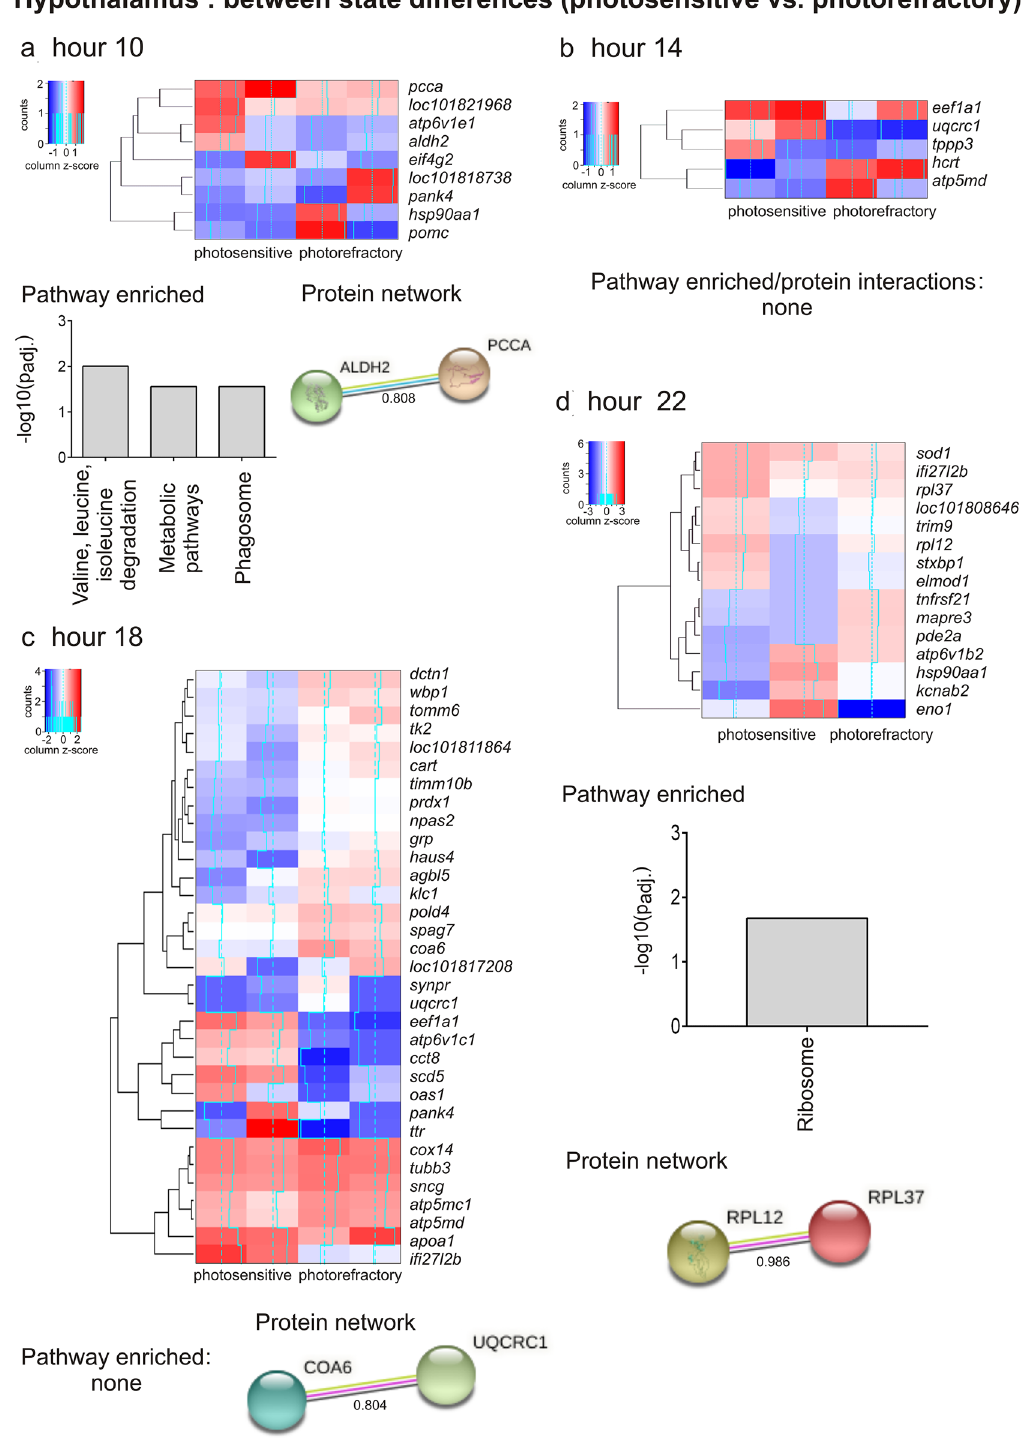
Figure 4. Heatmap of differentially expressed genes (DEGs) in the hypothalamus of bunting exhibiting photosensitive and photorefractory states (rows) at hours 10 ( a ), hour 14 ( b ) and hour 18 ( c ) and hour 22 (column) ( d ) (n = 2/time point/state except at hour 22 in the photorefractory state in which n = 1). Log- transformed values were normalized and plotted as z-scores (blue, minimum; red, maximum). A blue continuous line running through the heatmap shows expression differences from mean value (dashed line). Genes with similar expression patterns have been clustered together. Underneath each heatmap, the results of significantly enriched pathways ( p adj. < 0.05), and STRING DEG network analysis in which the nodes/ circles represent gene-encoded proteins, while the edge/lines connecting circles represent the protein–protein interactions. The empty nodes represent proteins of an unknown 3D structure, while the filled nodes represent the known or a predicted 3D